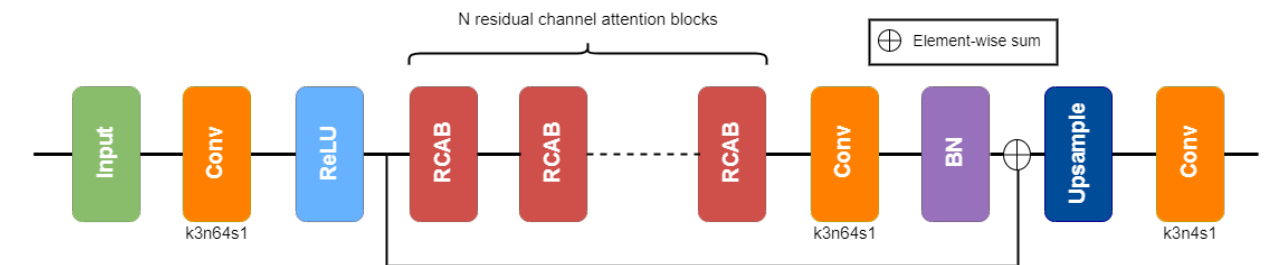
Figure 5. Architecture of SARNet. The baseline model uses 8 RCABs followed by a convolutional layer and a batch normalization layer to stabilize the training. The upsampling block is formed by one upsampling layer in the case of 2 × super-resolution and by two upsampling layer in the case of 4 ×